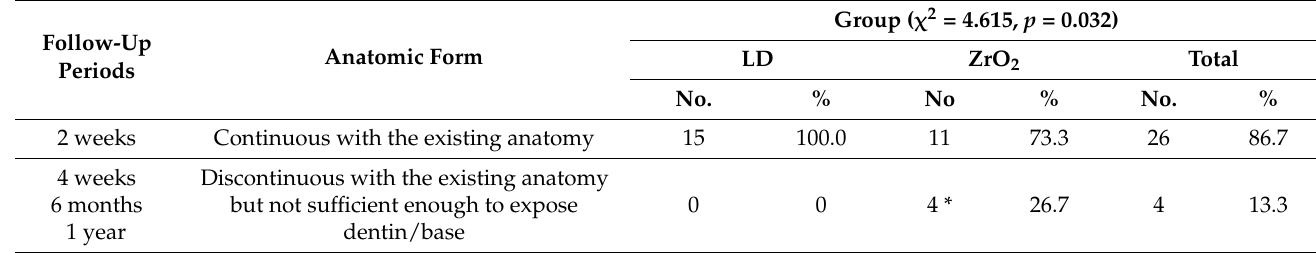
Table 6. The anatomic form in the study